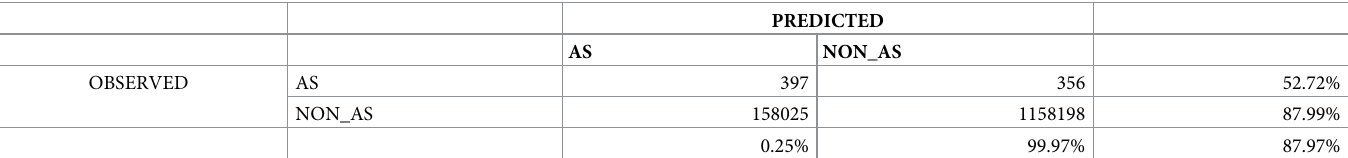
Table 5. Female all